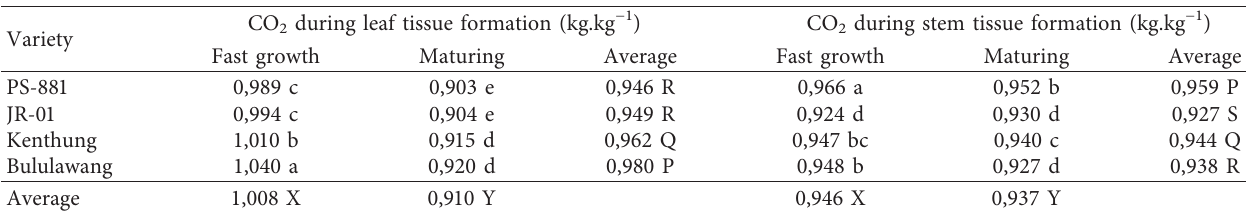
Table 3: Carbon dioxide released during the leaf and stem tissue formations on the fast-growing and maturing phases. Variety